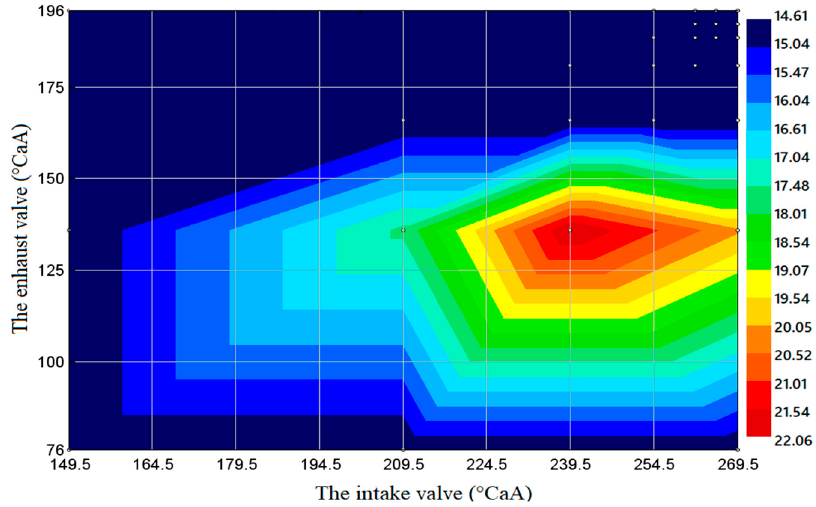
Figure 16. 50% load condition.